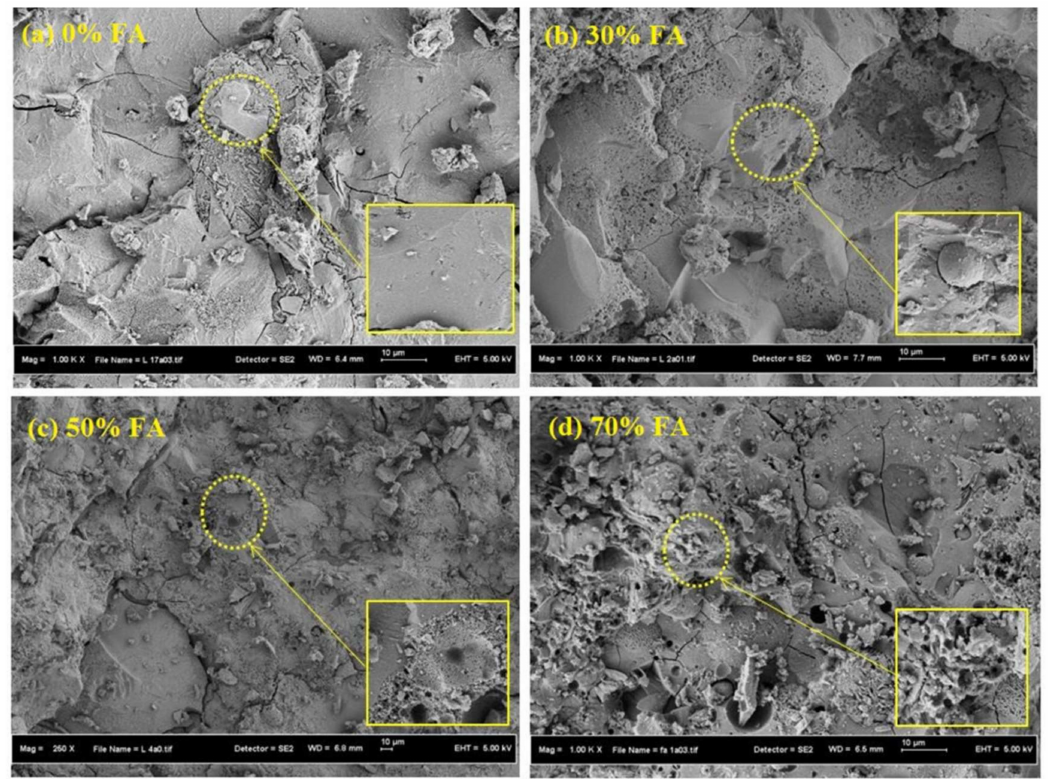
Figure 3. Microstructure of GGBS-based SCAAMs with ( a ) 0%, ( b ) 30%, ( c ) 50% and ( d ) 70% FA